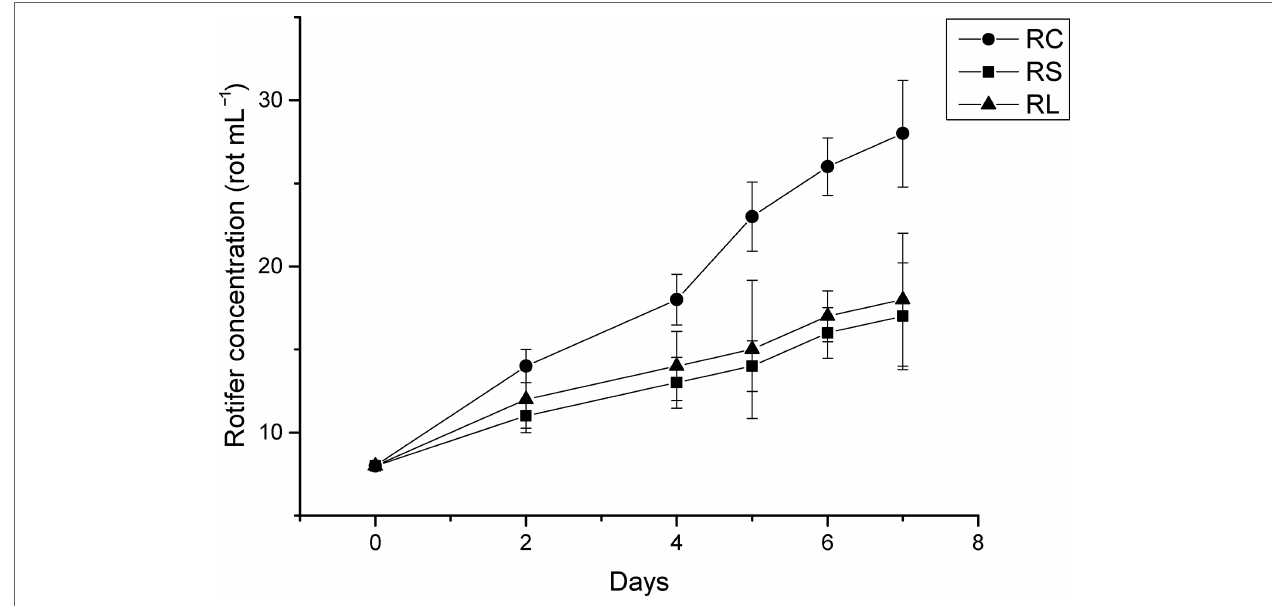
FIGURE 7 | The growth curve of rotifer B. plicatilis under different treatment treatments. RC, rotifer fed with CK; RS, rotifer fed with ST; RL, rotifer fed with